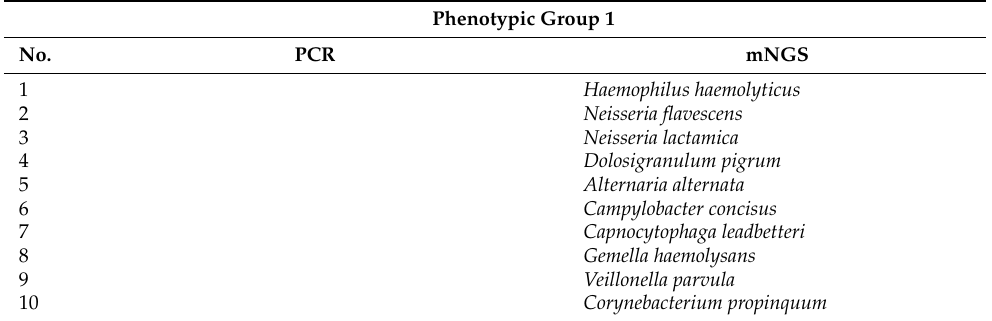
Table 3. PCR vs mNGS phenotypic grouping of upper respiratory tract